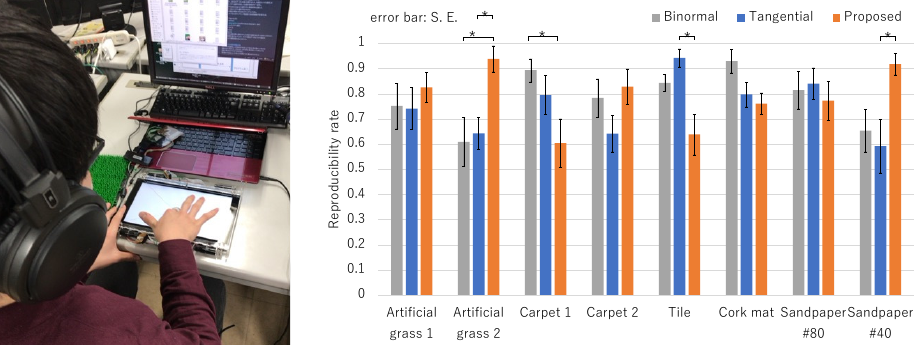
Figure 3. Left: an overview of the experiment, right: comparison results of reproducibility rating between methods. * in the figure shows a significant result at α < 0.05 in Tukey’s